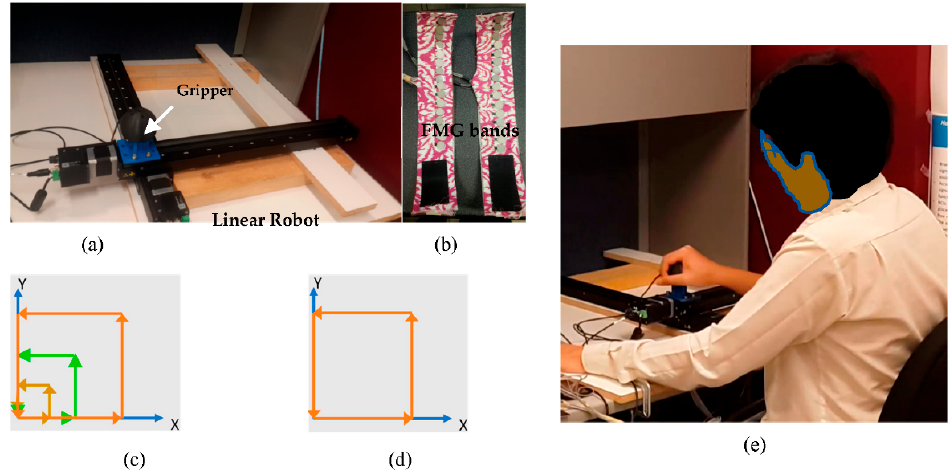
Figure 2. Setup used for data collection and evaluation of SFMG-DTL: ( a ) linear robot with gripper and end-effector on top, ( b ) two FMG bands, ( c ) interaction force in square motion SQ-1 with variable sizes in domain adaptation, ( d ) interaction force in square motion SQ-2 in domain generalization, and ( e ) participant P 1 interacting with the robot by applying force in dynamic SQ-1 motion.